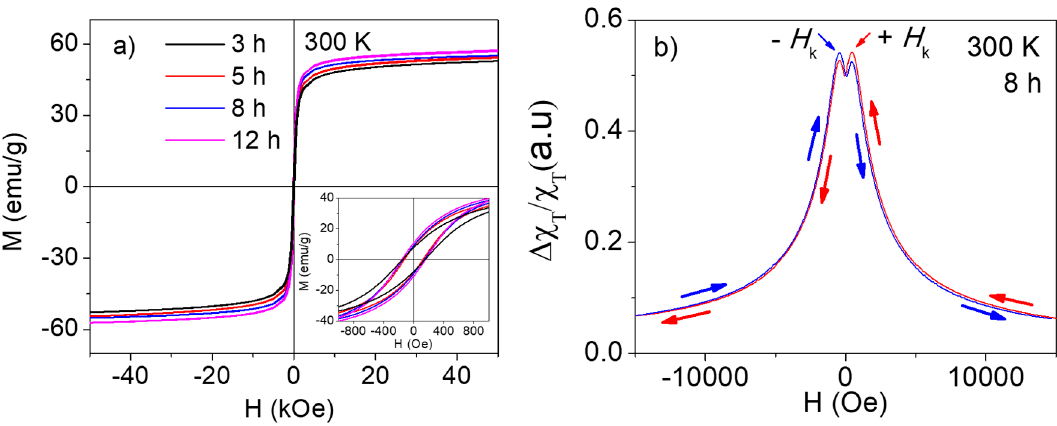
Figure 3. ( a ) Magnetic hysteresis loops of the multigrain Fe 3 O 4 nanorings after different hydrothermal reaction times, measured at 300 K. ( b ) Representative bipolar transverse susceptibility (TS) curves taken at 300 K for multigrain Fe 3 O 4 nanorings after 8 h of reaction. Inset of ( a ) shows the low-field region of the hysteresis loops.